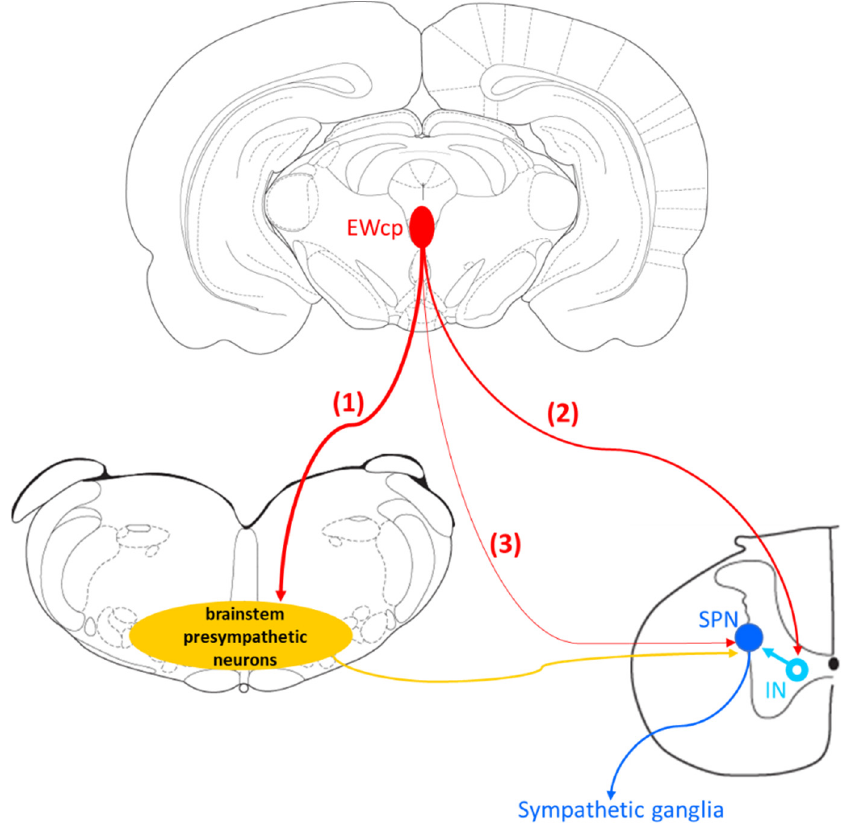
Figure 3. EWcp is part of the central circuit that controls sympathetic-innervated targets. There are several possible pathways for the early infection of EWcp after PRV injection in organs/tissues: (1) via indirect multisynaptic pathway through brainstem presympathetic neurons; (2) via direct projections to interneurons in the spinal cord; or (3) via sparse direct projections to SPNs in the IML. Infection of EWcp neurons at later survival times might include multisynaptic pathways. Abbreviations: IN, interneuron; SPN, sympathetic preganglionic neuron. Coronal section templates were obtained from the rat brain atlas from Paxinos and Watson, 3rd ed.